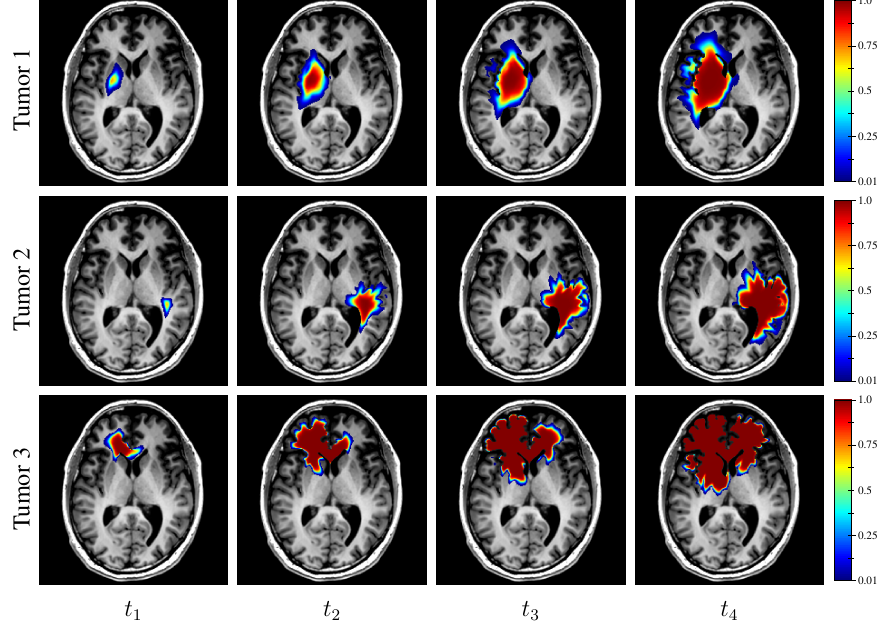
Figure 4. Examples of simulated tumor cell-density distributions at times t 1 − 4 (1st to 4th columns, axial slices) from the MR data of the same subject as in Figures 1 and 2. The corresponding model parameter values are provided in Table